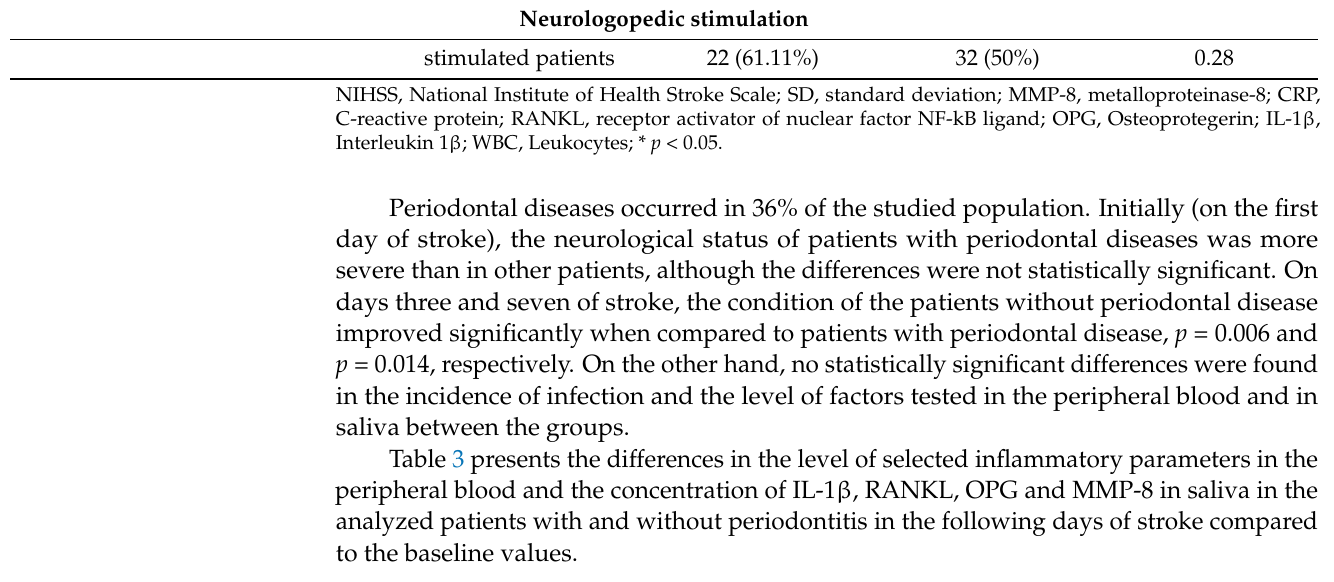
Table 3. The differences between the following time points and day 1 (baseline) of CRP level and white blood cells in the blood and RANKL, OPG, IL-1 β and MMP-8 concentration in saliva in the group of patients with and without periodontal